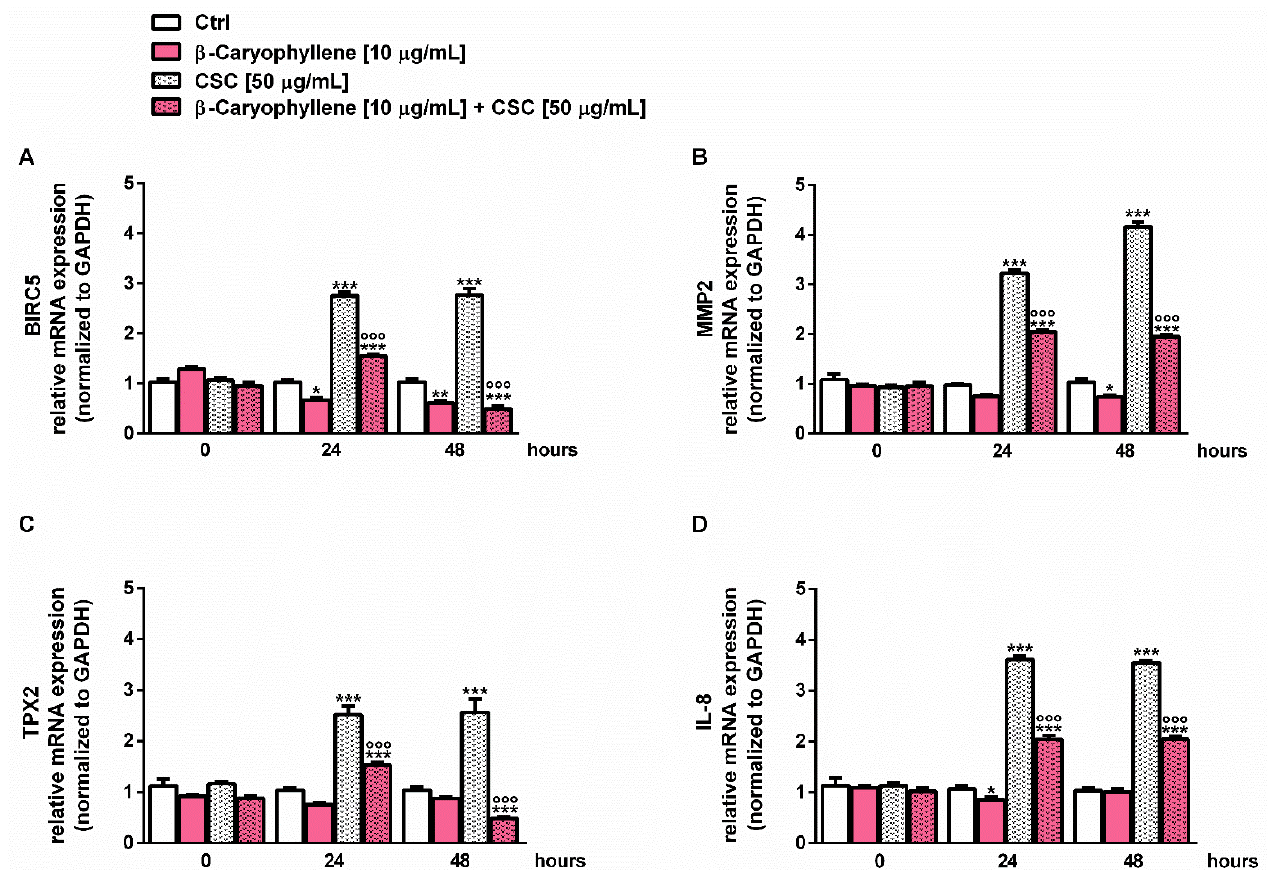
Figure 16. RTPCR analysis of cell migration factors BIRC5 ( A ), MMP2 ( B ), TPX2 ( C ), and IL-8 ( D ) induced by cigarette smoke condensate (CSC) and β -caryophyllene in MDA-MB-468 cancer cells after 24 h exposure. Data are displayed as mean ± SE of at least three independent experiments with at least three technical replicates ( n = 9). * p < 0.05, ** p < 0.01 and *** p < 0.001, significant lowering of cell viability with respect to the control (ANOVA + Dunnett’s multiple comparison post -hoc test). °°° p < 0.001, significant difference respect to CSC (Student’s t -test).